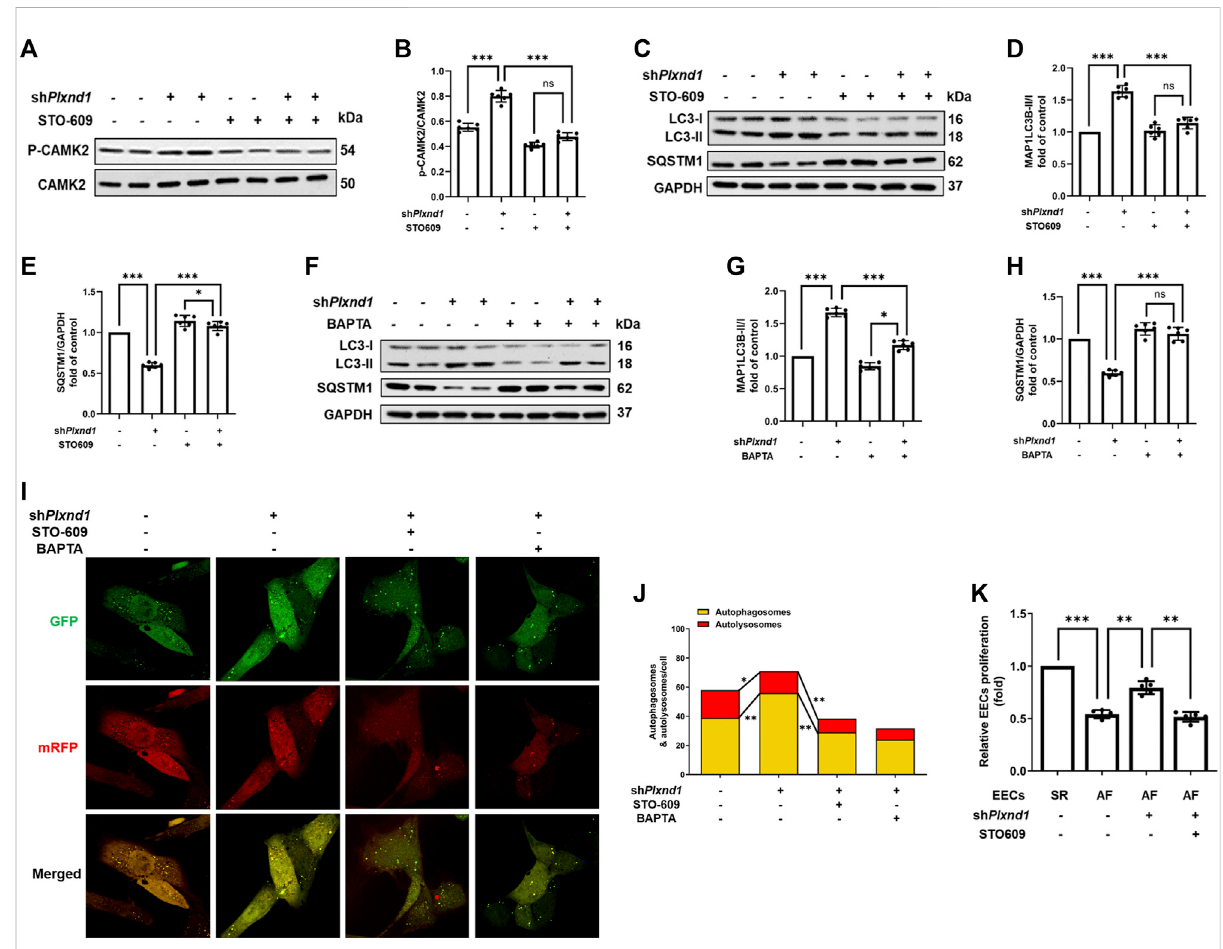
FIGURE 5 Decrease in CAMK2 phosphorylation is associated with PLXND1-mediated autophagic inhibition and endocardial endothelial cell dysfunction. (A – B) Representative WB and quanti fi cation of PLXND1-mediated CAMK2 activity in cells subjected to treatment with STO-609 or no treatment. (C – E) Representative WB and quanti fi cation of PLXND1-mediated autophagic marker levels in cells subjected to treatment with STO-609 or no treatment. (F – H) Representative WB and quanti fi cation of PLXND1-mediated autophagic marker levels in cells subjected to treatment with BAPTA or no treatment. (I – J) EECs were infected with a tandem GFP-mRFP-LC3 adenovirus for 24 h. Representative merged images (I) and quantitative analysis (J) of yellow and free red puncta in merged images in the treated groups. Scale bar: 10 μ m. (K) EECs from SR and AF mice were seeded in E-plates, and the normalized cell index was recorded in real time for different treatment groups. CAMK2, calmodulin-dependent protein kinase II; PLXND1, plexinD1; WB, western blot; AF, atrial fi brillation; SR; sinus